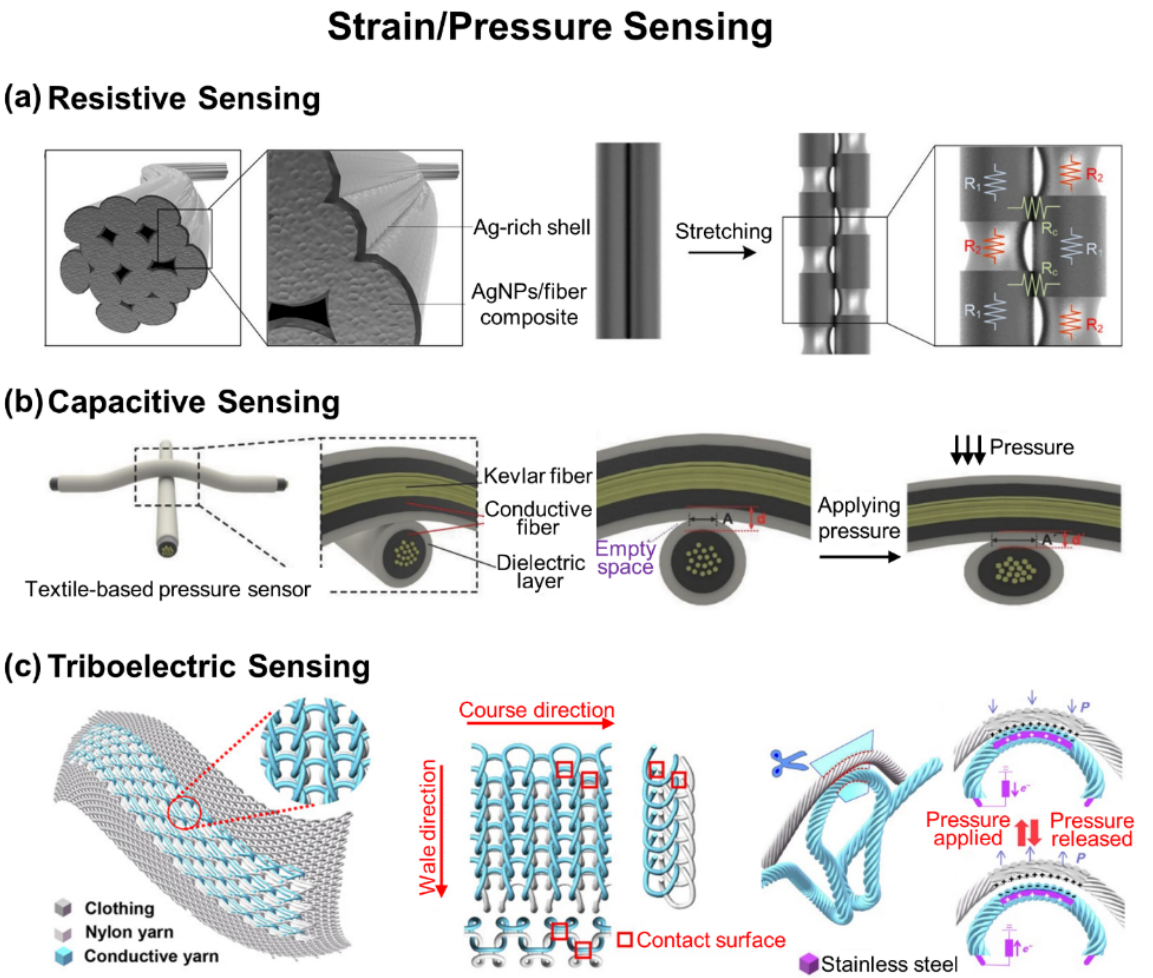
Figure 3. E-textiles for strain and pressure sensing. ( a ) Resistive sensing with an Ag NP/fiber composite/Ag-rich shell fiber. Reprinted with permission from [75]. Copyright 2018 American Chemical Society. ( b ) Capacitive sensing with an Ag NP/SBS/Kevlar fiber. Reprinted with permission from [63]. Copyright 2015 Wiley-VCH. ( c ) Triboelectric sensing with a Terylene-twisted stainless- steel/nylon yarn. Reprinted with permission from [68]. Copyright 2020 American Association for the Advancement of Science.